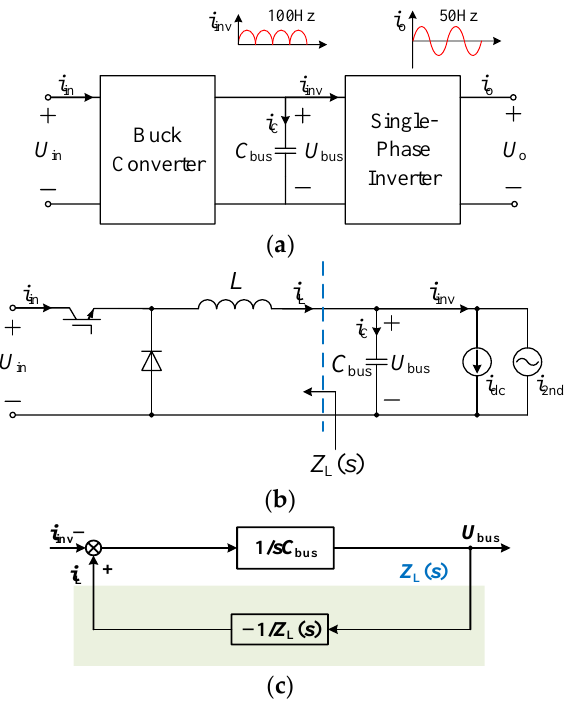
Figure 1. Two-stage inverter. ( a ) Configuration; ( b ) equivalent schematic diagram; ( c ) block diagram for Z L ( s ).